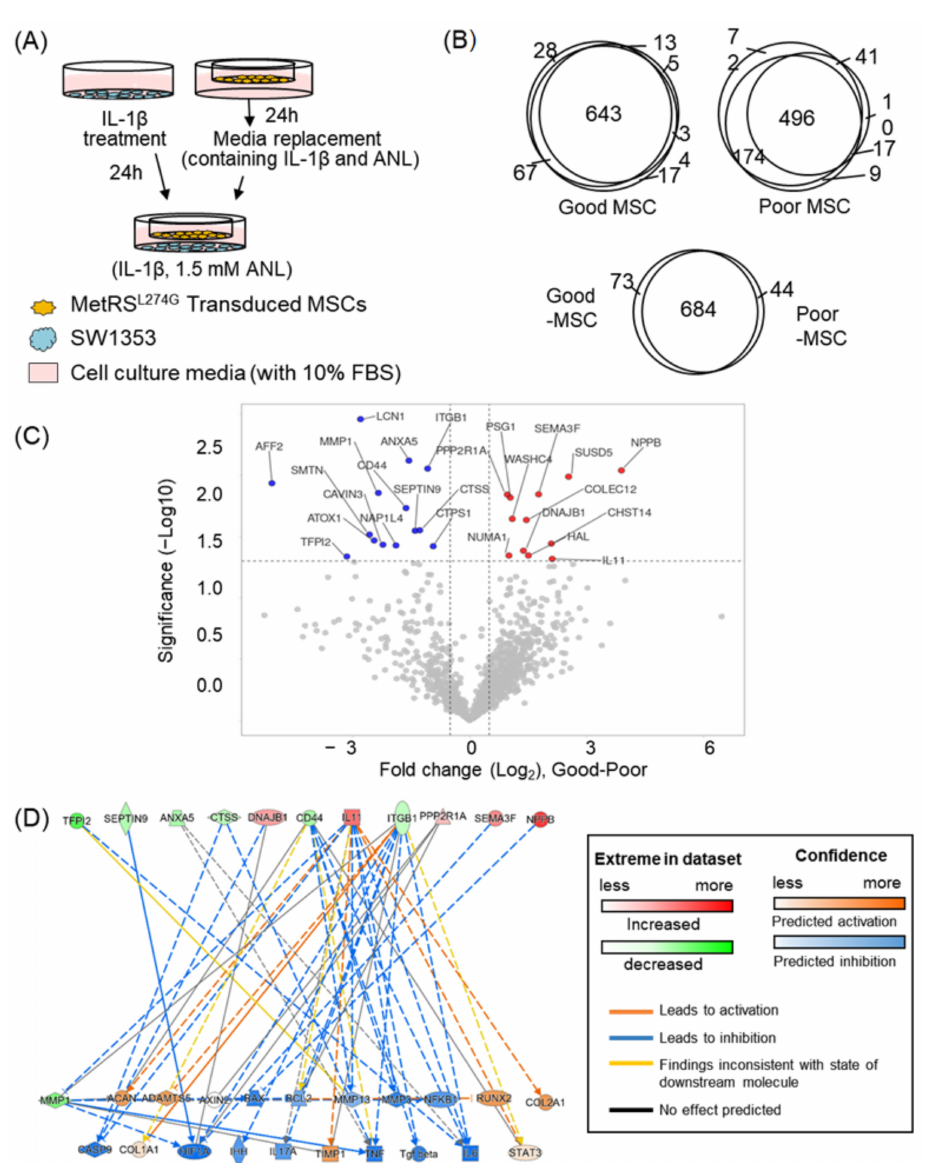
Figure 5. Analysis of secretome from MSCs co-cultured with osteoarthritis (OA)-induced cells. ( A ) Schematic workflow for analyzing secretome of MSCs that were co-cultured with OA-induced SW1353 cells. IL-1 β was treated to induce OA. ( B ) The number of proteins identified in secretome of three good MSCs and three poor MSCs, as well as their inter- or intra-overlap; 90.4% of the identified proteins in the secretome of good MSCs were also identified in the secretome of poor MSCs. ( C ) Volcano plot displaying − log10 ( p -value) vs. log2 (fold change, good MSCs over poor MSCs) for the identified proteins in the secretome of MSCs. Daggers indicate differentially expressed proteins between the two MSCs groups. Red and blue dots indicate proteins with increased expressions and decreased expressions in good MSCs, respectively. ( D ) Prediction of expression levels of OA-related genes based on the secretome profile using the Ingenuity pathway analysis (IPA) tool. The genes identified in our secretome profile are colored either green or red, while the genes whose expression levels are predicted by IPA are colored either blue or